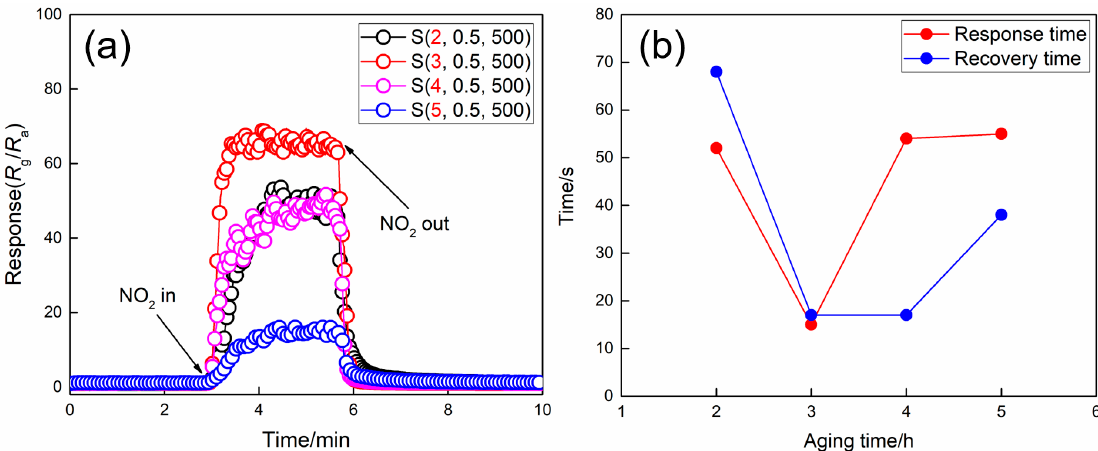
Figure 4. ( a ) Dynamic response/recovery curves and ( b ) response/recovery times of WO 3 films 170 at different aging times upon exposure to 5 ppm NO 2 at 100 ◦